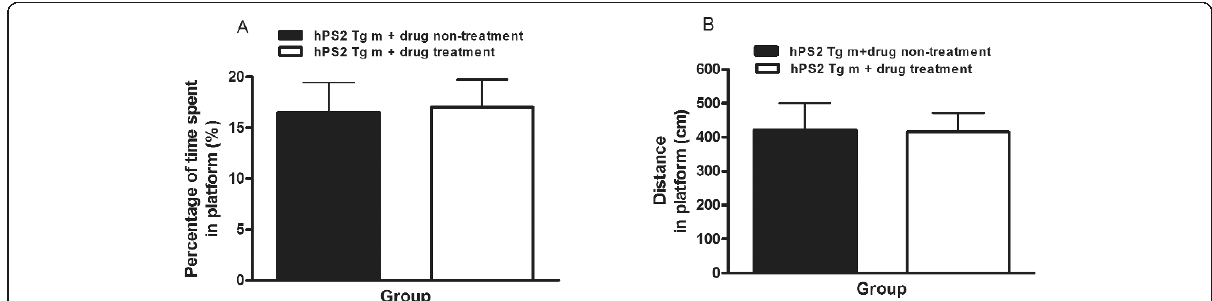
Figure 3 Alteration of time spent and distance around the platform and during the memory retention test in the water maze . Four trials were conducted on the fifth day without the platform and the search latency ( A ) and distance ( B ) were measured. Data are presented as mean ± SEM, and comparisons between the two groups were made using the unpaired t -test. * P < 0.05, compared to the drug treated-hPS2 transgenic mice.